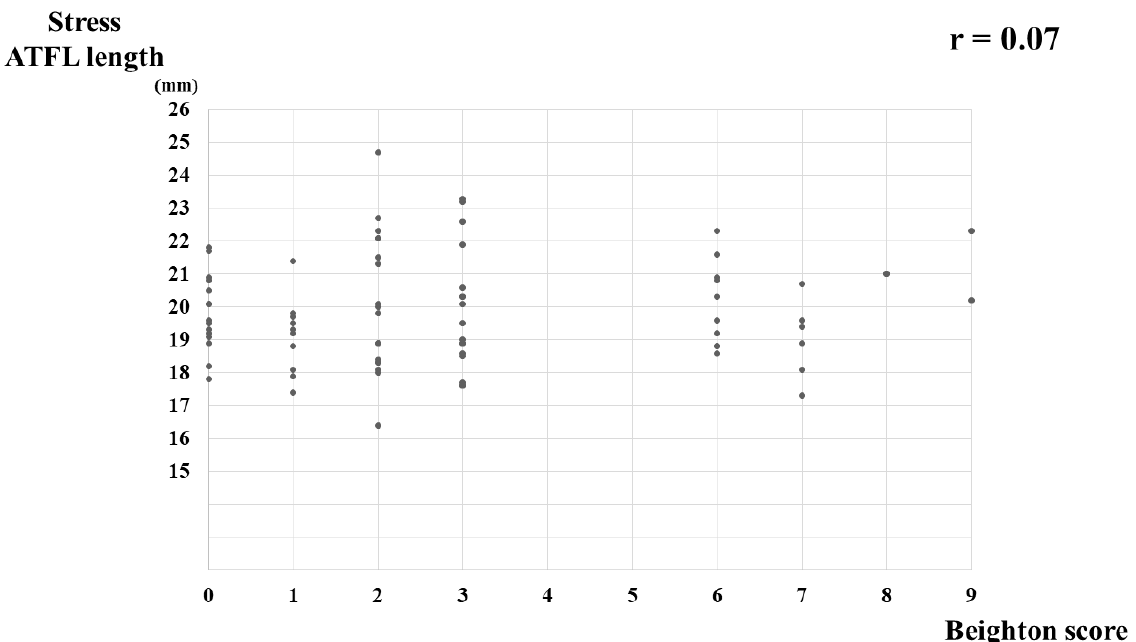
Figure 4. Correlation between the Beighton score and stress ATFL length in healthy young women. ATFL, anterior talofibular ligament.